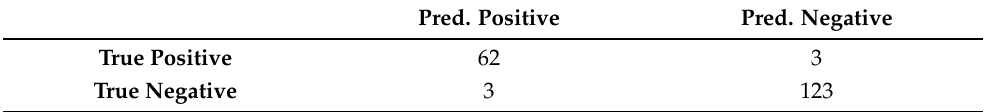
Table 5. Confusion matrix for the testing set without the cases labeled as “Others”: CNN VGG16. Pred. Positive